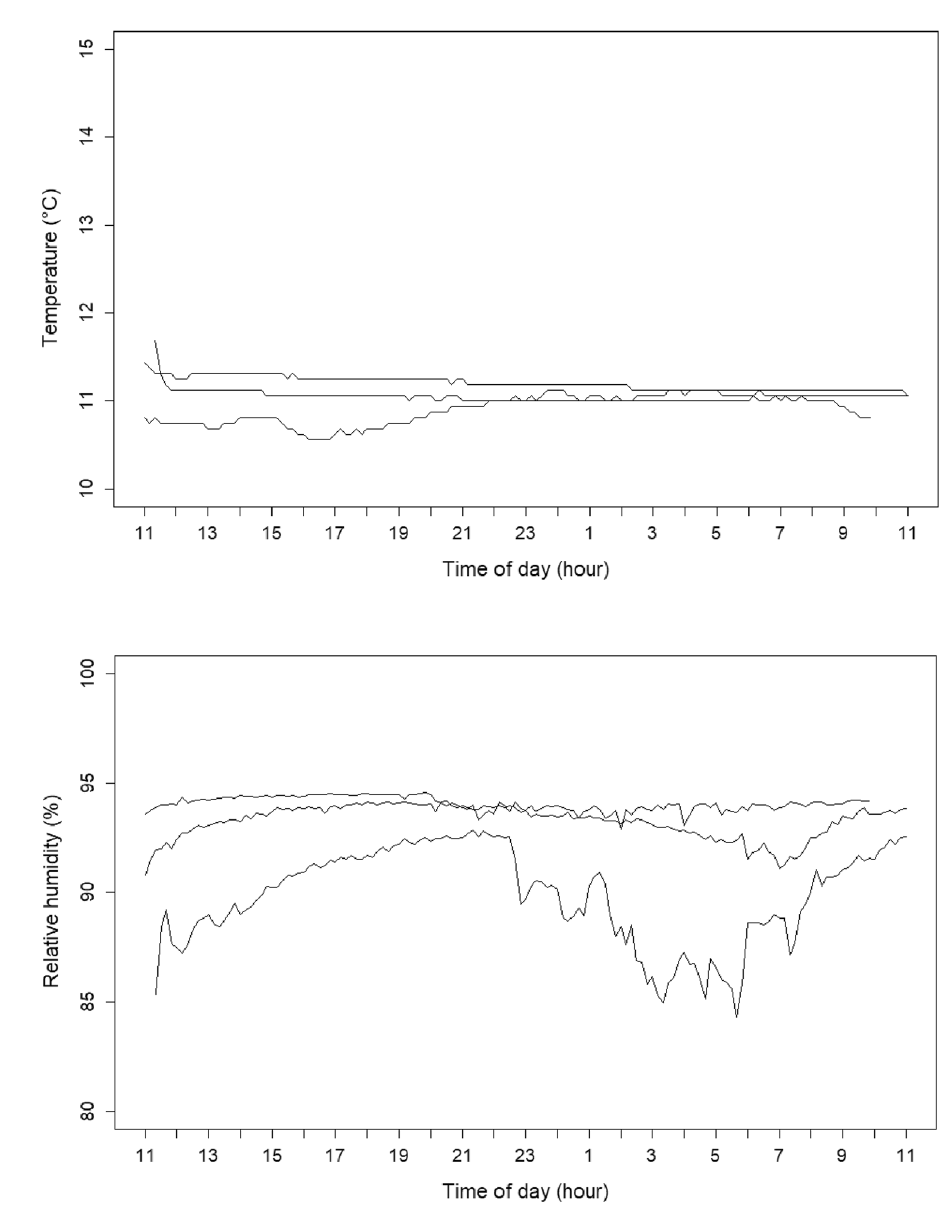
Fig. 8 Air temperature data collected from within three